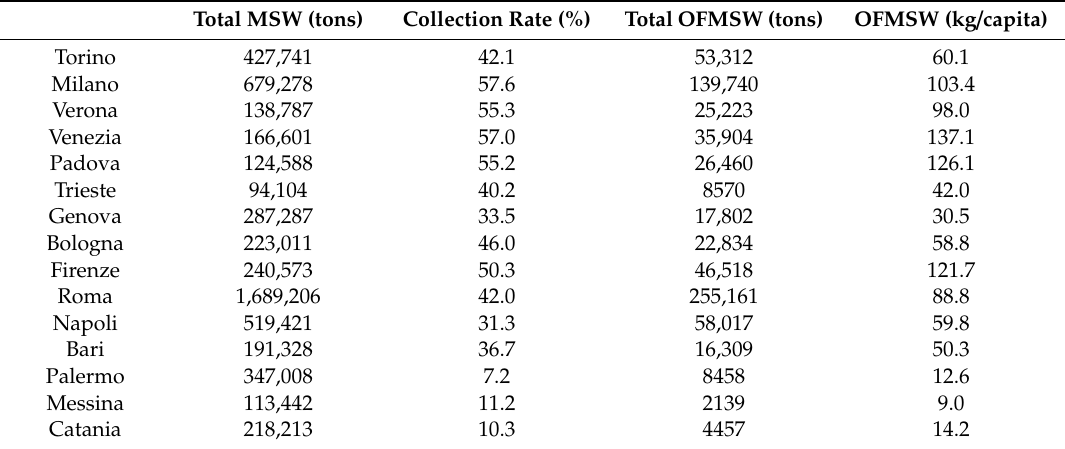
Figure 2. Map of 15 Italian municipalities. Table 3. Statistical data in 15 Italian municipalities in 2016 [67].